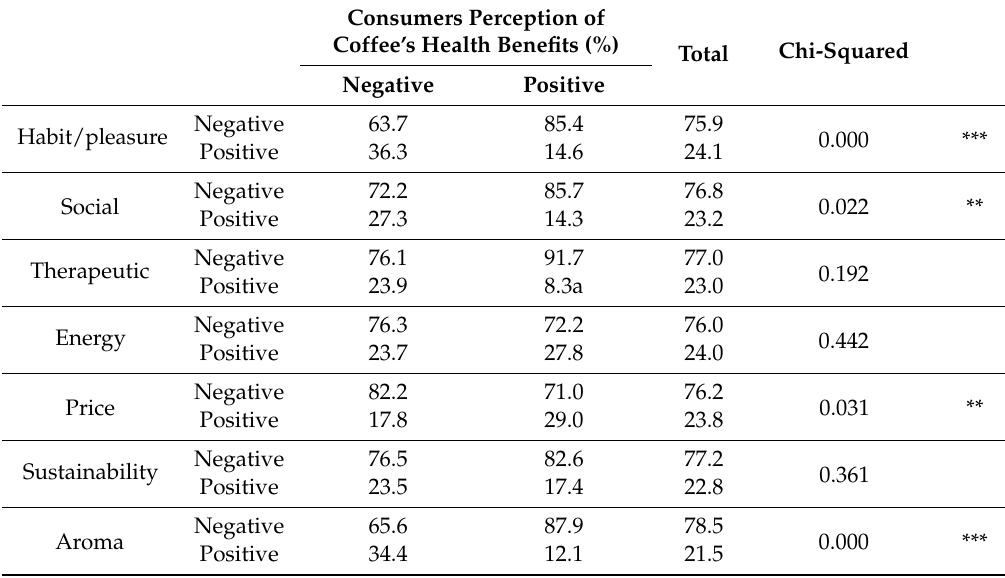
Table 8. Relationship between consumers’ perception of coffee health benefits and motives for coffee consumption and purchasing, with chi-squared